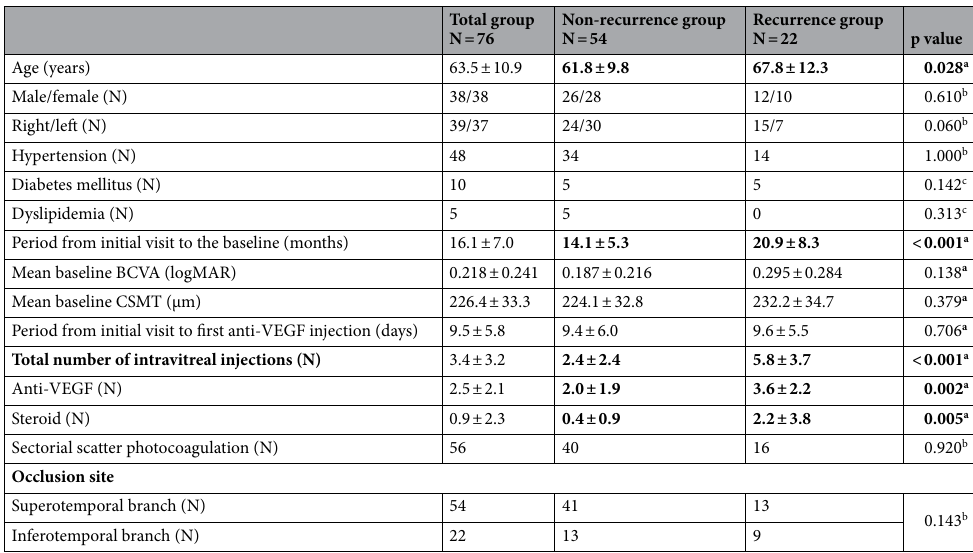
Table 1. Baseline characteristics of patients with chronic branch retinal vein occlusion. BCVA best-corrected visual acuity, CSMT central subfield macular thickness, VEGF vascular endothelial growth factor. Bold font indicates a statistically significant difference (a p value < 0.05) between the non-recurrence and recurrence groups. a The results of the Mann–Whitney U test. b The results of Pearson chi-squared test. c The results of the Fisher’s exact probability test.